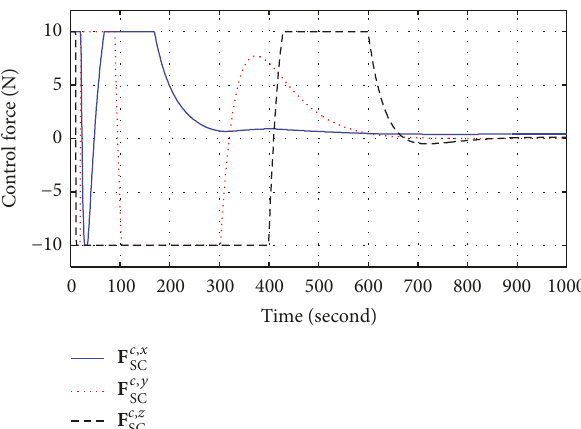
Figure 8: Components of control force on the three axes of the